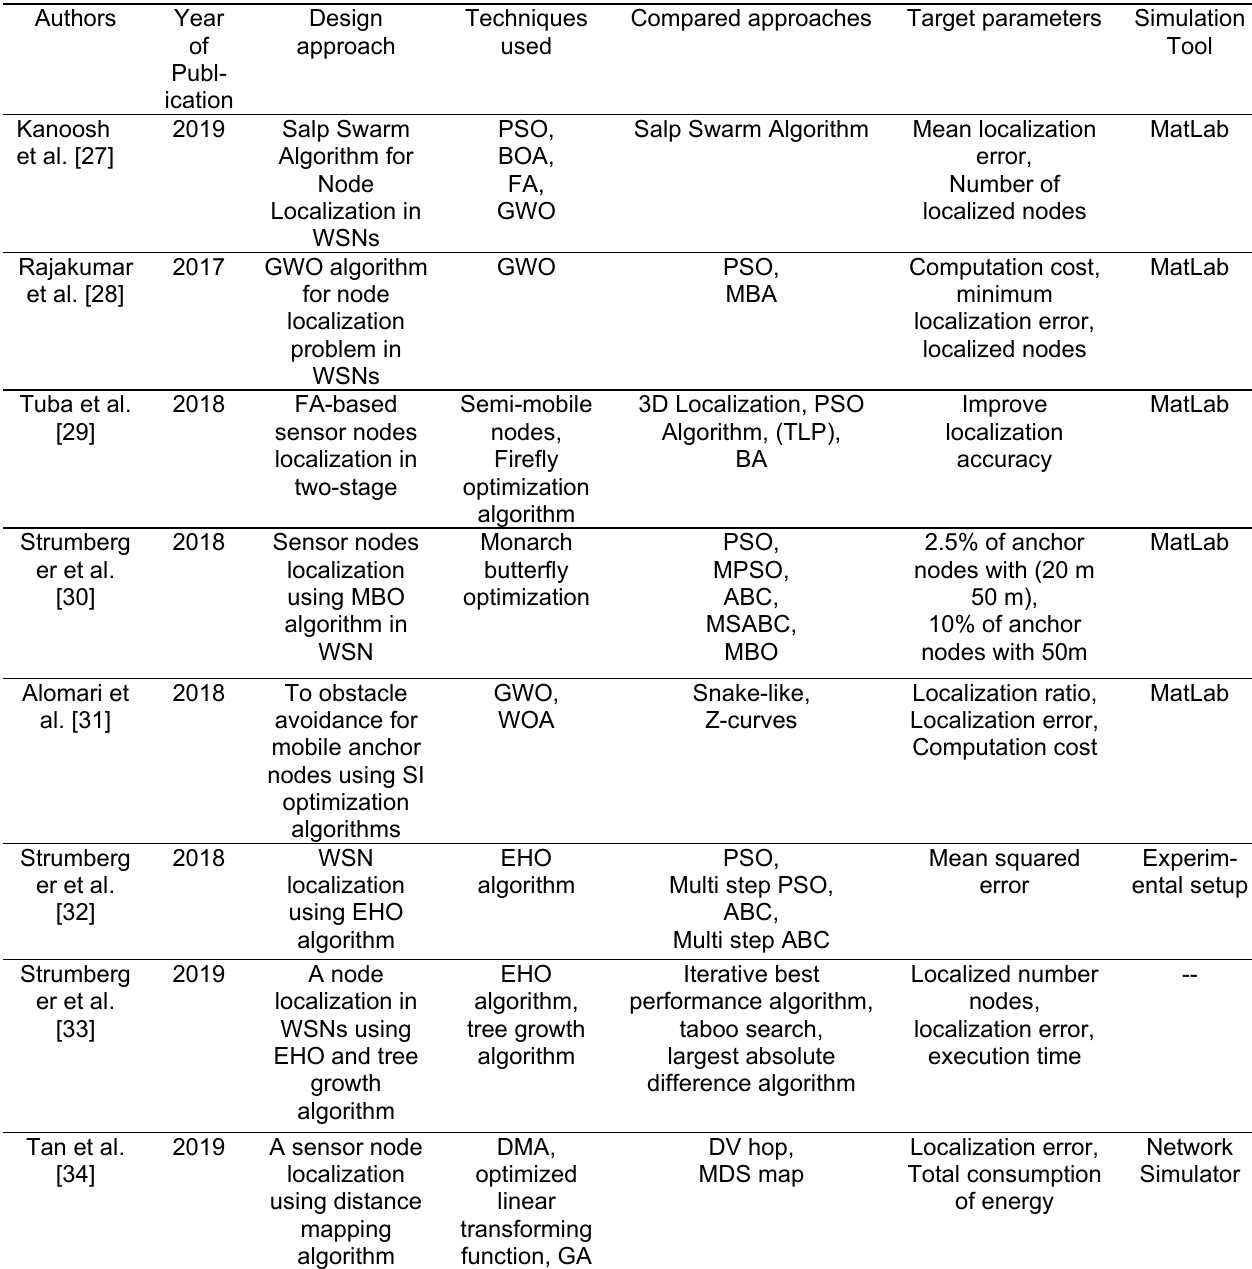
Table 1. Taxonomy of anchor-based sensor nodes localization approaches for sensor nodes using computational intelligence algorithms in